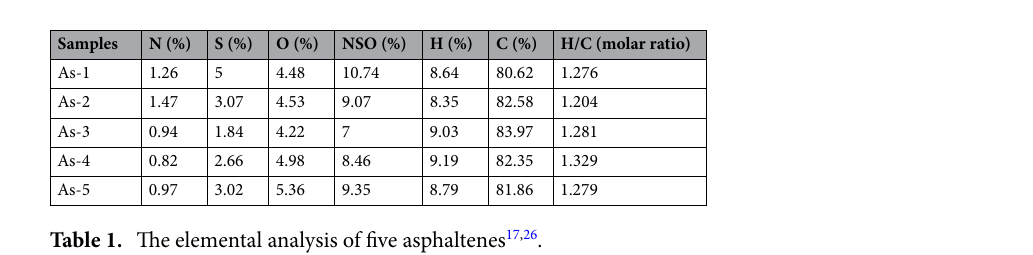
Table 1. The elemental analysis of five asphaltenes 17,26